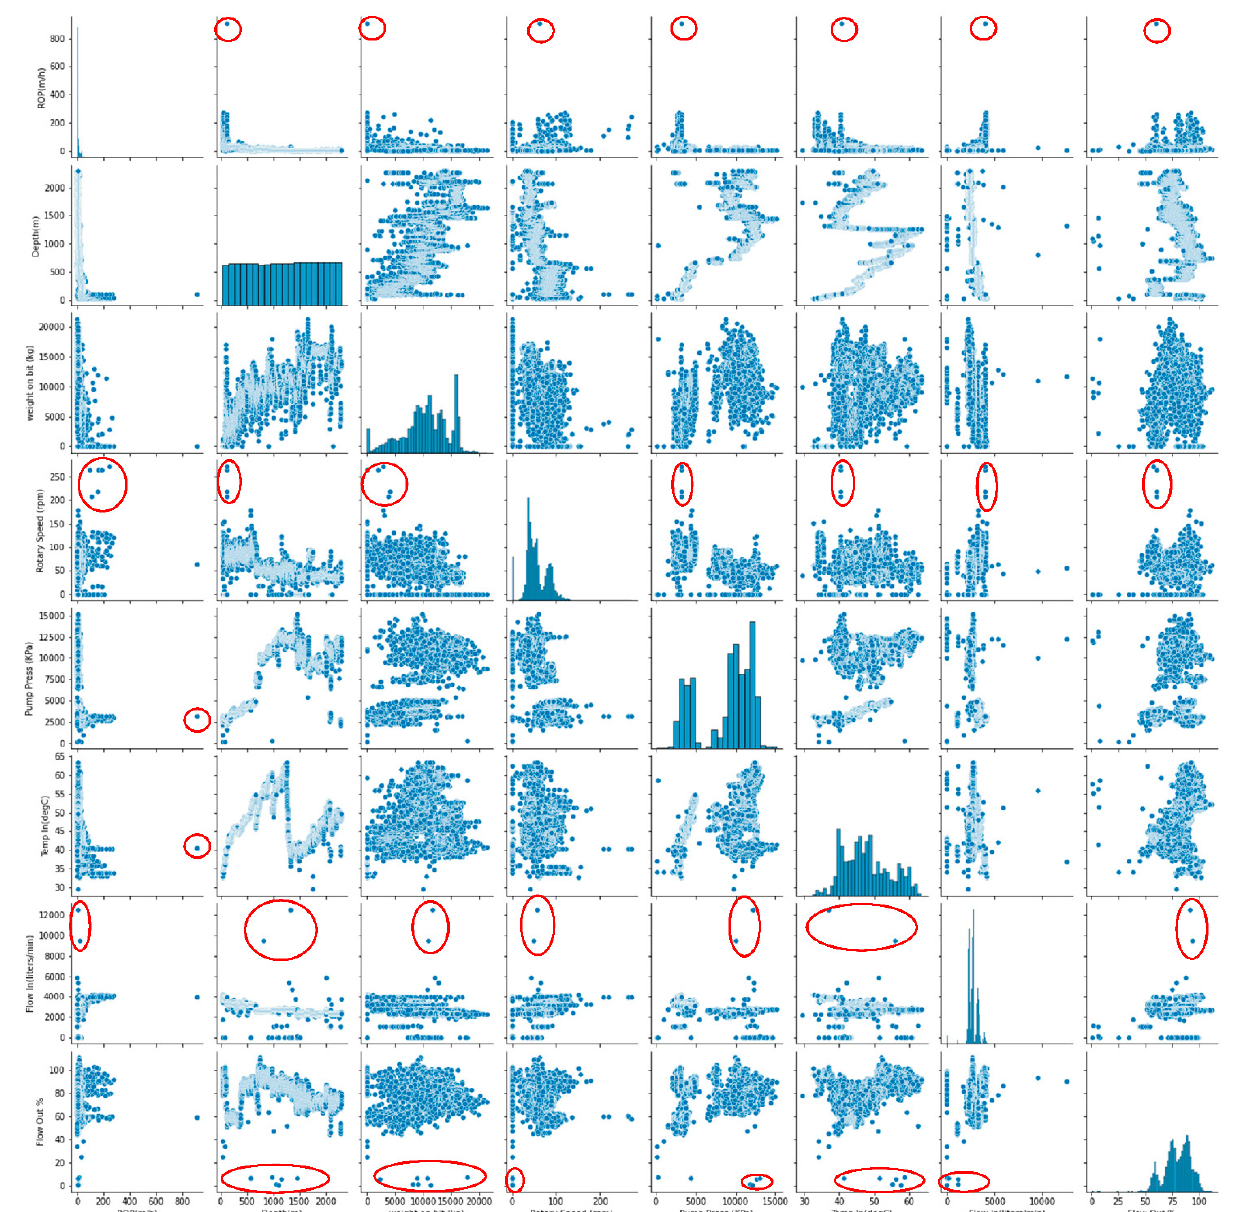
Figure 7. Pair plot of our drilling dataset with the encircled outliers.